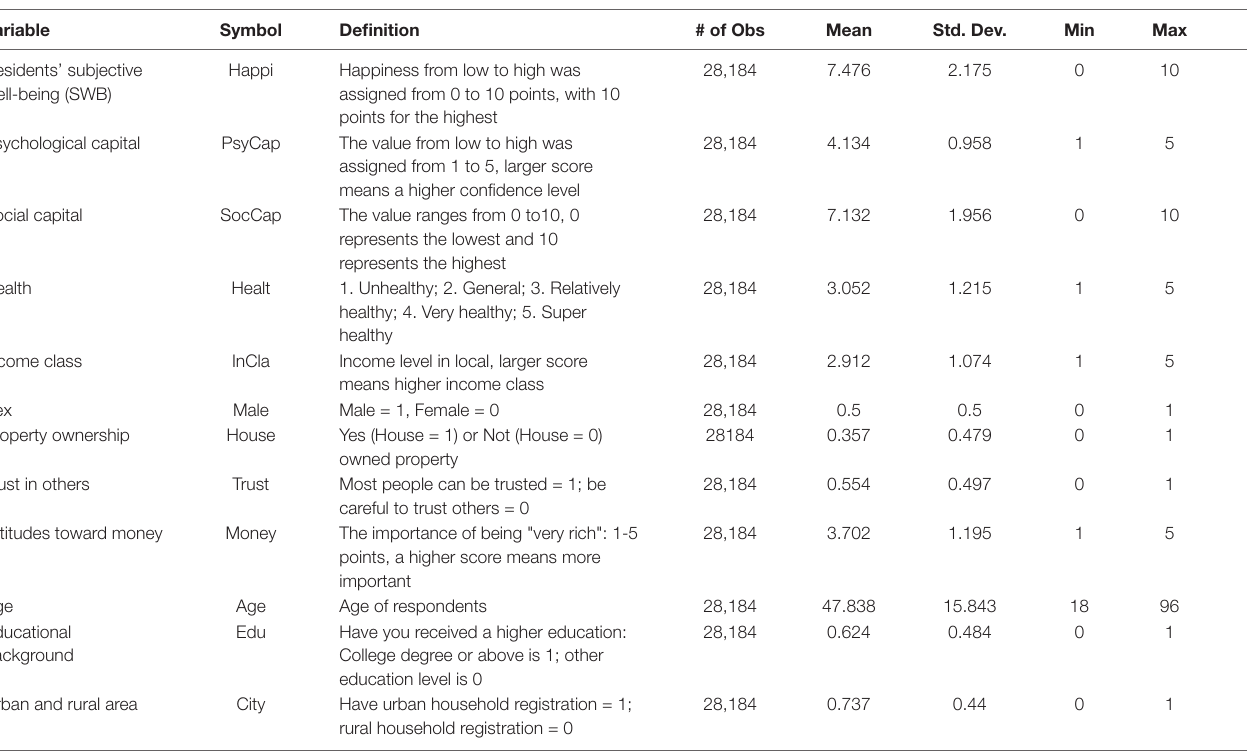
TABLE 1 | Descriptive statistics.